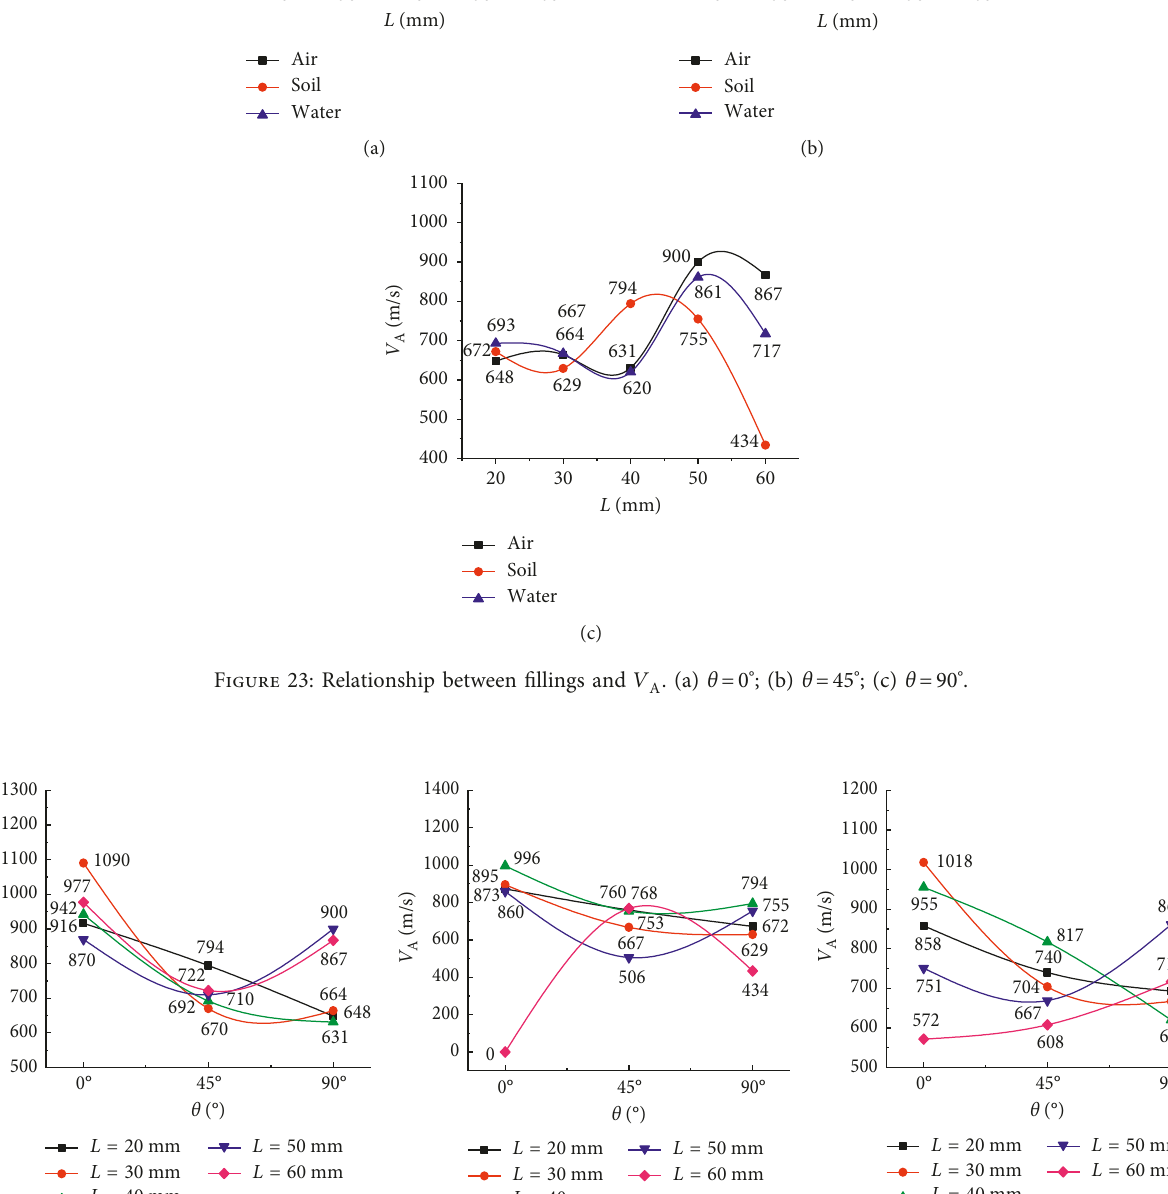
. (a) Air; (b) soil; (c) A